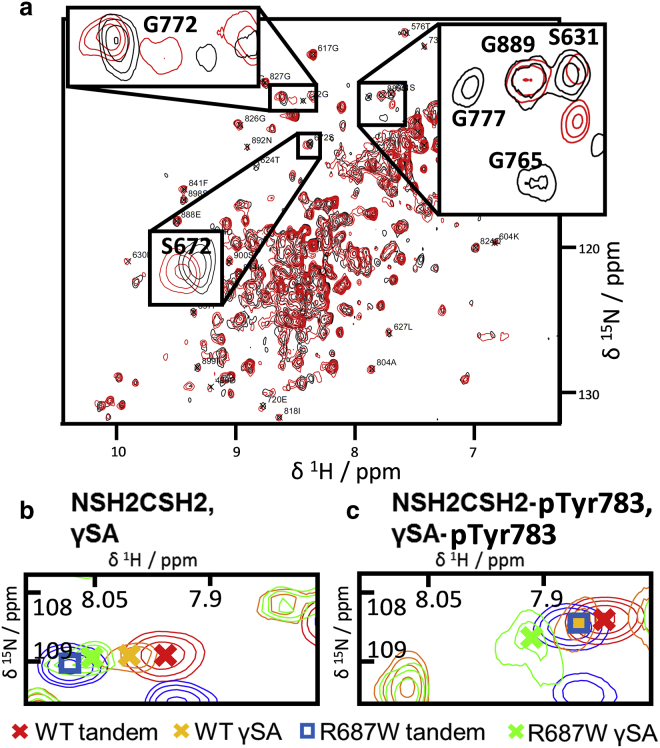
The NMR observations made in context of tandem- nSH2-cSH2 constructs are reflected in 1H,15N-NMR spectra for the γ-specific array (γSA). (a) 1H,15N-SOFAST-HMQC spectra of γSA (red) and γSA-pY783 (black) are shown. Spectra were recorded at 950 MHz at 25°C. Further backbone crosspeak assignments for nonphosphorylated γSA can be found elsewhere (10). (b and c) 1H,15N-SOFAST-HMQC crosspeaks of residue Gly777 in nonphosphorylated (b) and phosphorylated (c) tandem- or γSA constructs are shown. Symbols depict the crosspeak centroids (color key depicted below). The “closed” state is less populated in nonphosphorylated and R687W mutant constructs than in the corresponding phosphorylated and WT constructs. Spectra were recorded at 34°C (b) or 25°C (a and c) and at 700 MHz (b) or 950 MHz (a and c).